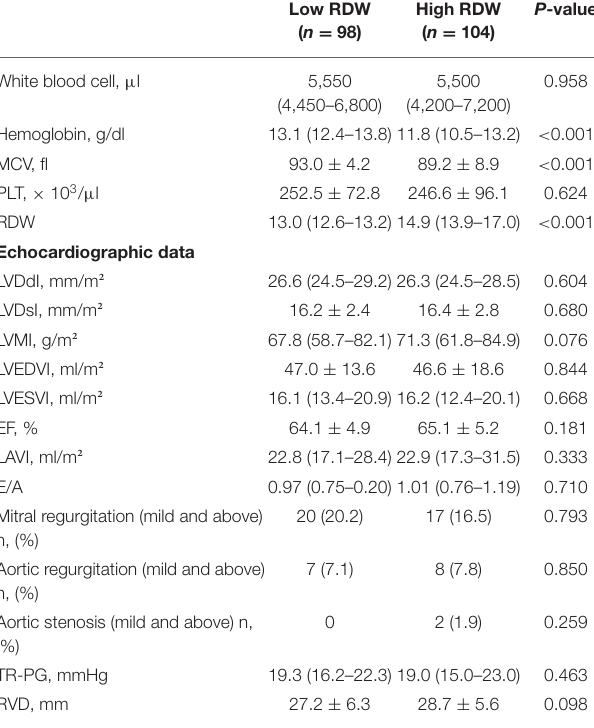
Values are indicated by mean ± SD, median with interquartile range or n (%). Monoclonal antibodies include HER2 inhibitor. Radiation therapy includes only irradiation to the mediastinum.Hemato-oncologicdiseaseincludeHodgkindisease,Non-Hodgkindisease, acute myeloid leukemia, acute lymphocytic leukemia, and chronic lymphocytic leukemia. Gynecologic tumor include uterine cancer or sarcoma and ovarian cancer. Other solid tumors include thymoma, soft tissue tumor, teratoma. ACE, angiotensin-converting enzyme; ARB, angiotensin II receptor blocker; BNP, B- type natriuretic peptide; CAD, coronary artery disease; CKD, chronic kidney disease; eGFR, estimated glomerular filtration rate; GLS, global longitudinal strain; HER2,